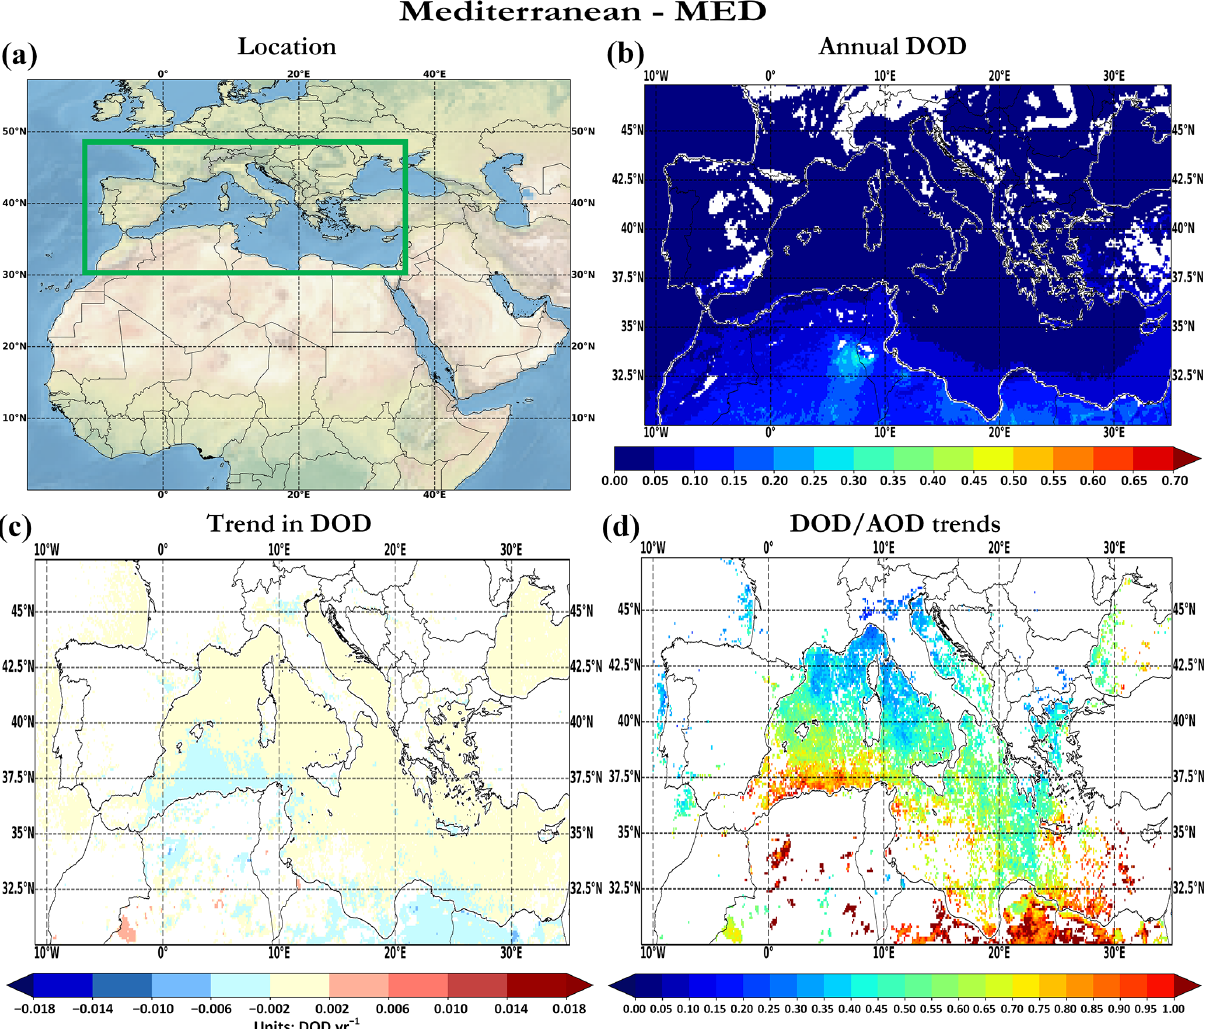
Figure 16. Same as Fig. 10, but for the Mediterranean